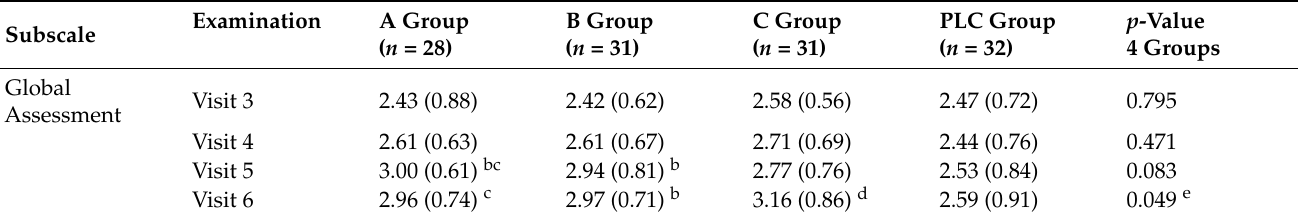
Table 6. Investigator Global Assessment Scale scores at baseline and follow-up visits among the four groups a .